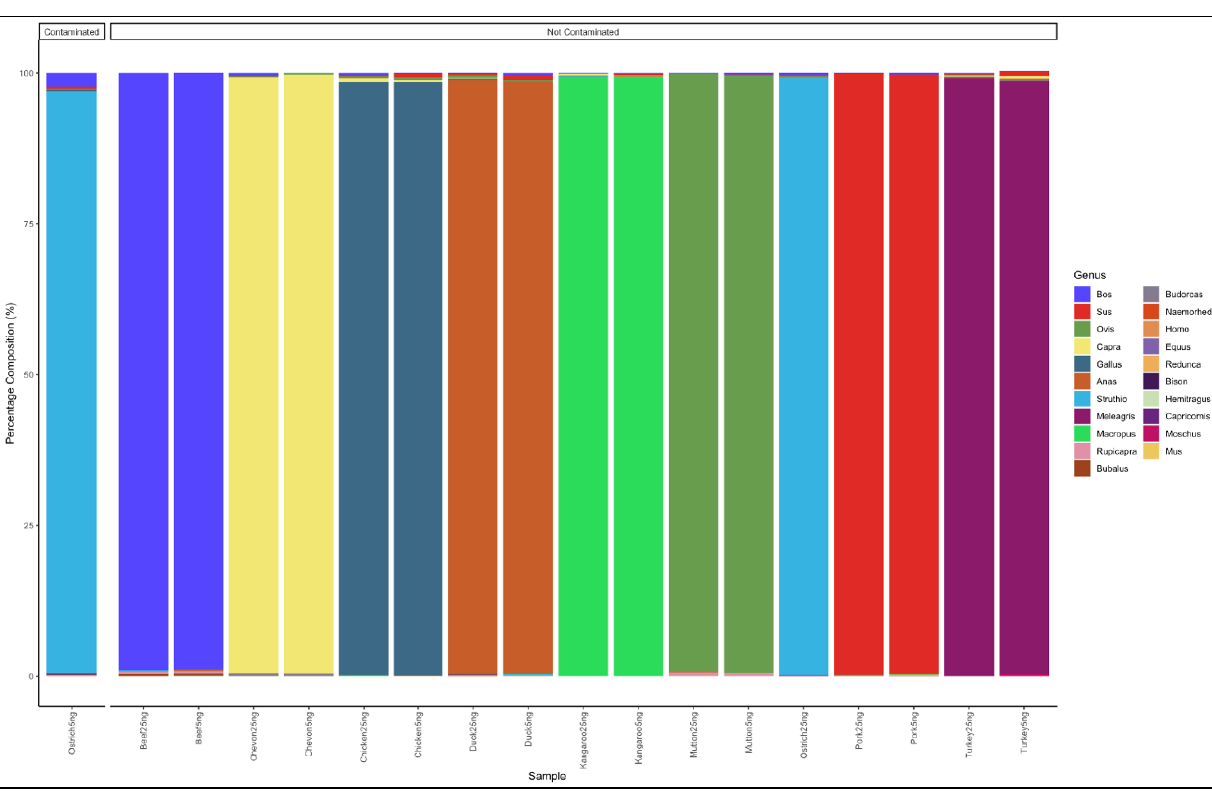
Figure 2. Percentage average fold of pure DNA from known meat types.